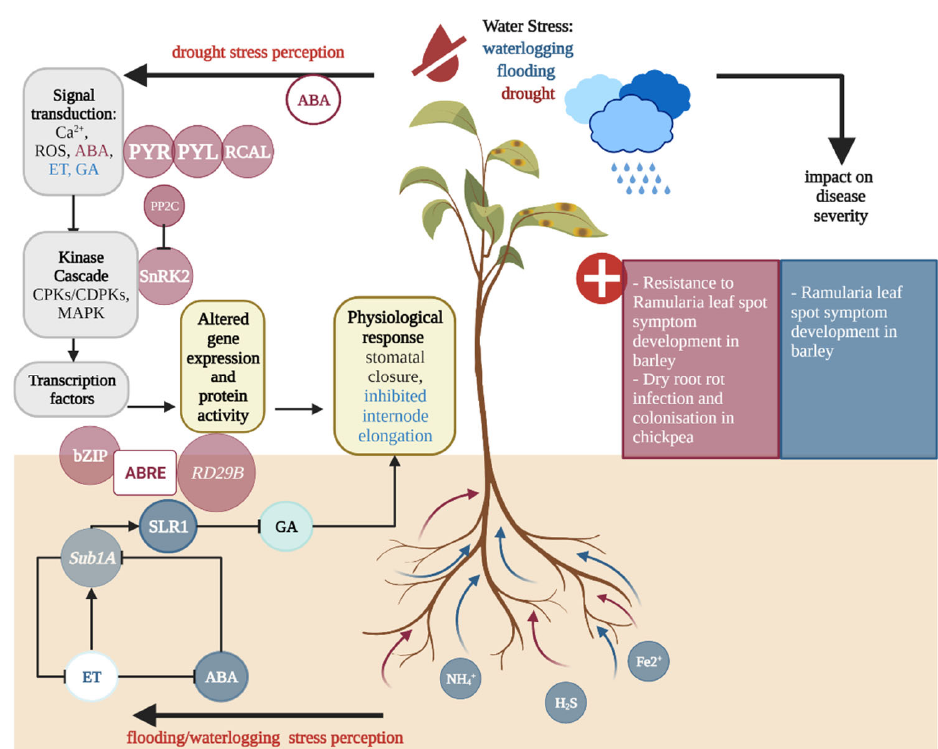
Figure 2. Overview of the impact of host water stress signalling pathways and the impact of water stress on Dothideomycete-induced disease severity. Figure 2 highlights the signalling pathways ( left ) and the effects of drought (dark red) and waterlogging and flooding (dark blue) on Dothideomycete-induced disease severity ( right ). Upon drought stress, calcium ions (Ca 2+ ) and abscisic acid (ABA) accumulate. The signalling cascade is initiated by ABA receptors such as the pyrabacting resistance (PYR)/PYR1-LIKE (PYL)/regulatory components of ABA (RCAL) proteins binding to ABA. In the presence of ABA, the PYR/PYL/RCAL complex interacts with a group of protein phosphatase 2Cs (PPC2s), which represses the activity of sucrose nonfermenting 1 (SNF1) related protein kinase 2 (SnRK2) and downstream ABA signalling. The activation of kinases such as SnRK2 leads to the activation of transcriptional factors that control drought stress responsive genes and modulates plasma membrane proteins in guard cells, resulting in stomatal closure. SnRK2 is an upstream activator of bZIP transcription factors with known ABA-responsive element binding factors (ABFs or AREBs), which play key roles in binding to cis-elements of promotor regions of ABA-responsive genes, such as the responsive to dehydration ( RD29B ) gene in A. thaliana. Similarly, waterlogging stress induces ABA synthesis in the root system, also leading to stomatal closure. In rice, it was shown that the expression of Submergence-1A ( Sub1A ) is induced during flooding by low levels of ethylene (ET), leading to an increase of the expression of slender rice 1 (SLR1), which is a known gibberellin suppressor that inhibits internode elongation during the short-term waterlogging